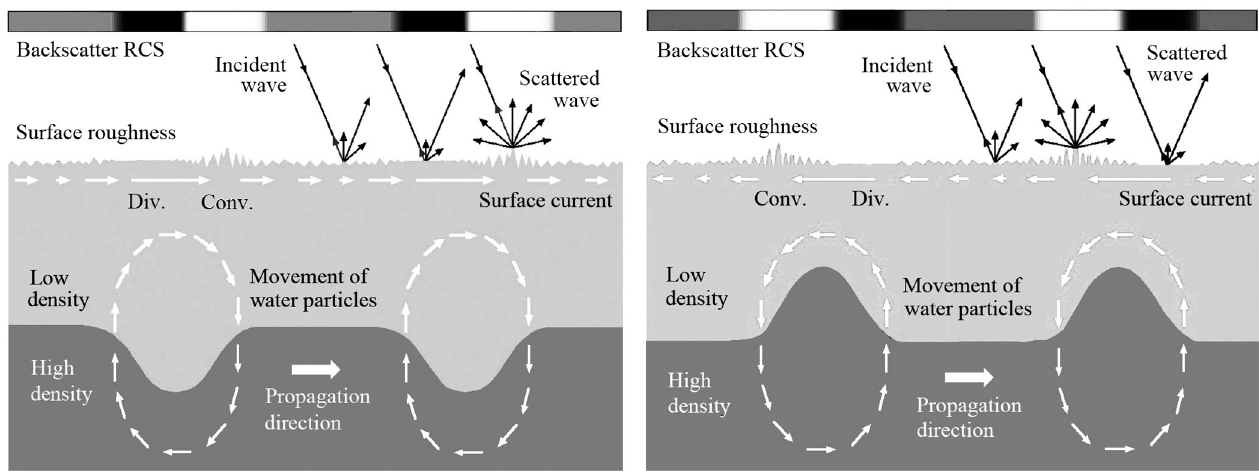
Figure 9. Imaging process of IWs by SAR. The varying surface roughness is caused by the circular motion of water particles as the internal wave propagates, resulting in the current converging and diverging areas. The current converging surface becomes rough compared with the diverging area. The image signatures depend on the depression ( left ) and elevation ( right ) of the pycnocline.